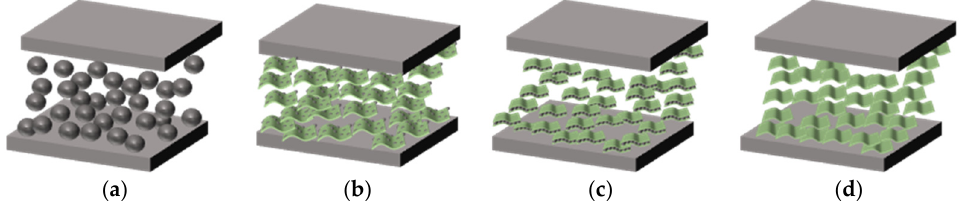
Figure 5. The main microscopic change process of nickel powder and graphene ratio. ( a ) Schematic diagram of the microstructure when nickel powder is filled alone. ( b ) Schematic diagram of the microstructure when nickel powder is in majority. ( c ) Schematic diagram of the microstructure when graphene is in majority. ( d ) Schematic diagram of the microstructure when graphene is filled alone.